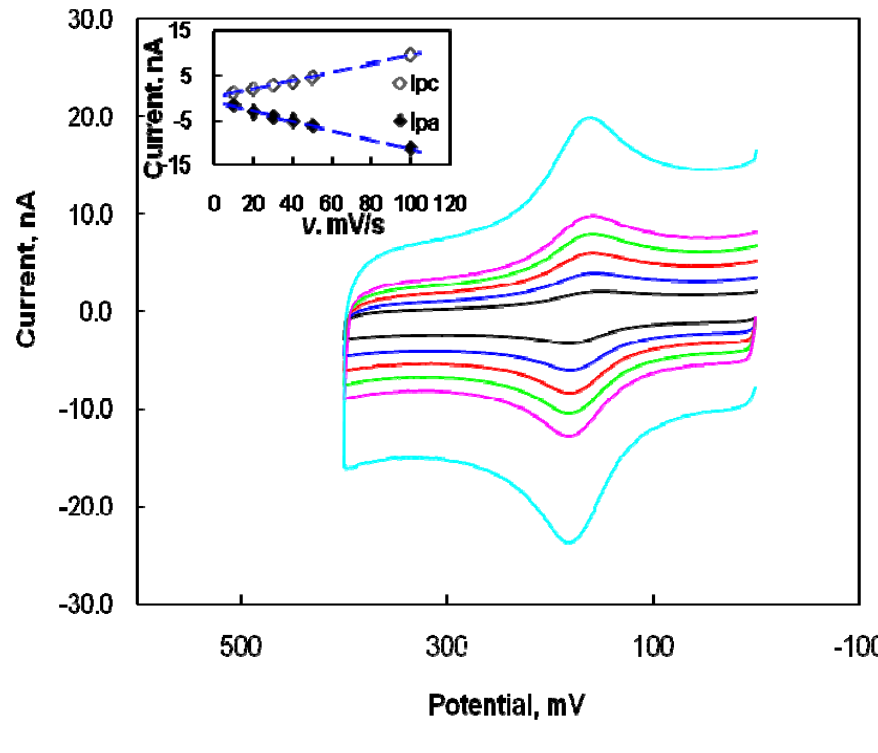
Figure 2. Cyclic voltammograms obtained at different scan rates from the modified microelectrode in a PBS solution at pH 7.4 containing 10  M DA. Scan rates: 10, 20, 30, 40, 50, and 100 mV/s. Inset: plots of anodic and cathodic peak currents as a function of scan